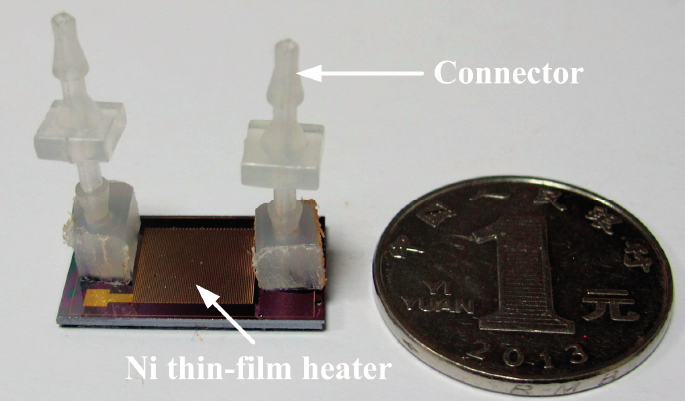
Figure 5. The prototype of the test